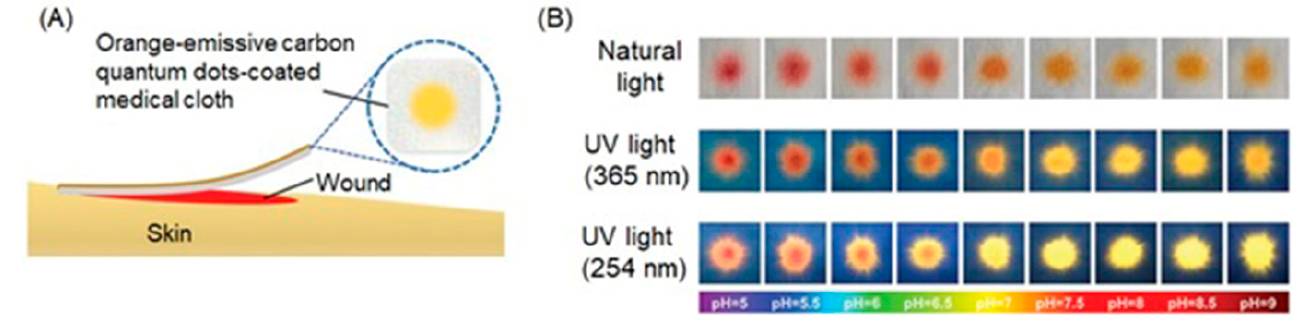
Figure 35. ( A ) Schematic representation of the medical cloth coated with quantum dots used in wound pH determination. ( B ) Photographs showing color under natural light and fluorescence images under UV light (excited at 365 and 254 nm) of the orange-emissive quantum dots in a buffer solution at different pH values. Adapted with permission from Yang, P.; Zhu, Z.; Zhang, T.; Zhang,